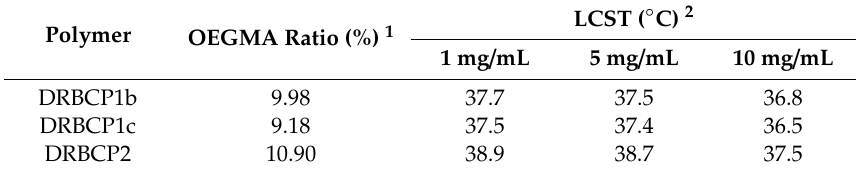
Table 3. LCST of DRBCPs with various incorporation ratio of OEGMA and